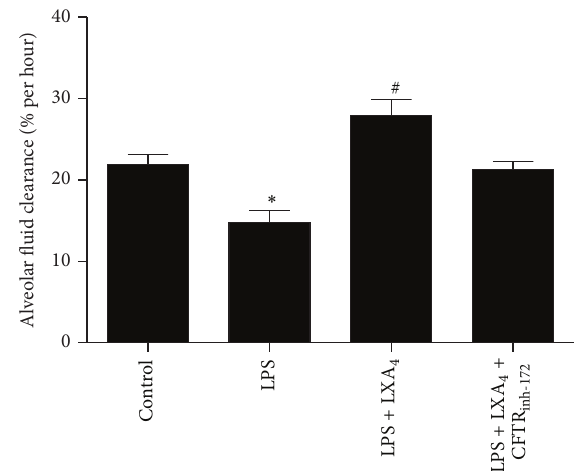
Figure 2: Effects of lipoxin A 4 on AFC in LPS-induced ALI. Lipoxin A 4 (2 𝜇 g/kg) was administered intravenously to Sprague-Dawley (SD) rats 6h after LPS (20 mL/kg) stimulation through the tail vein, and intratracheal instillation of 5% albumin solution containing Evans Blue-labeled albumin through a tracheostomy to the left was instilled with albumin lung, ventilating for 1 hour. CFTR inh- 172 solution. Data were expressed as mean ± SEM for each group. ∗ 𝑃 < 0.05 versus control group, # 𝑃 < 0.05 versus LPS group, 𝑛 = 8 for each group. LPS = lipopolysaccharide, LXA 4 = lipoxin A 4